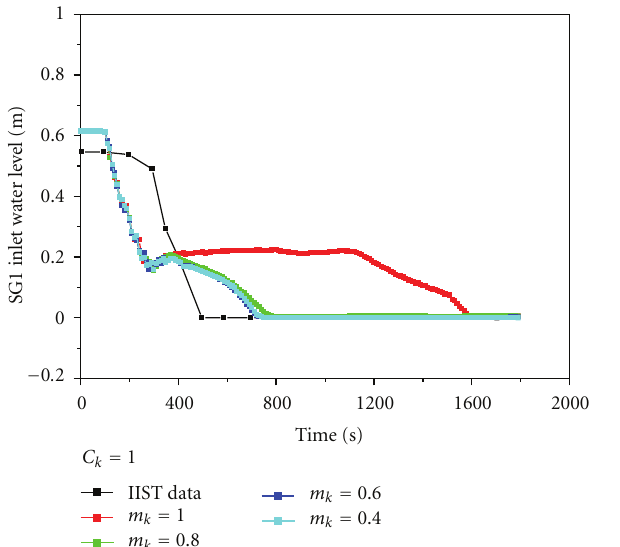
Figure 12: The CCFL sensitivity study of C k for SG1 inlet water level.